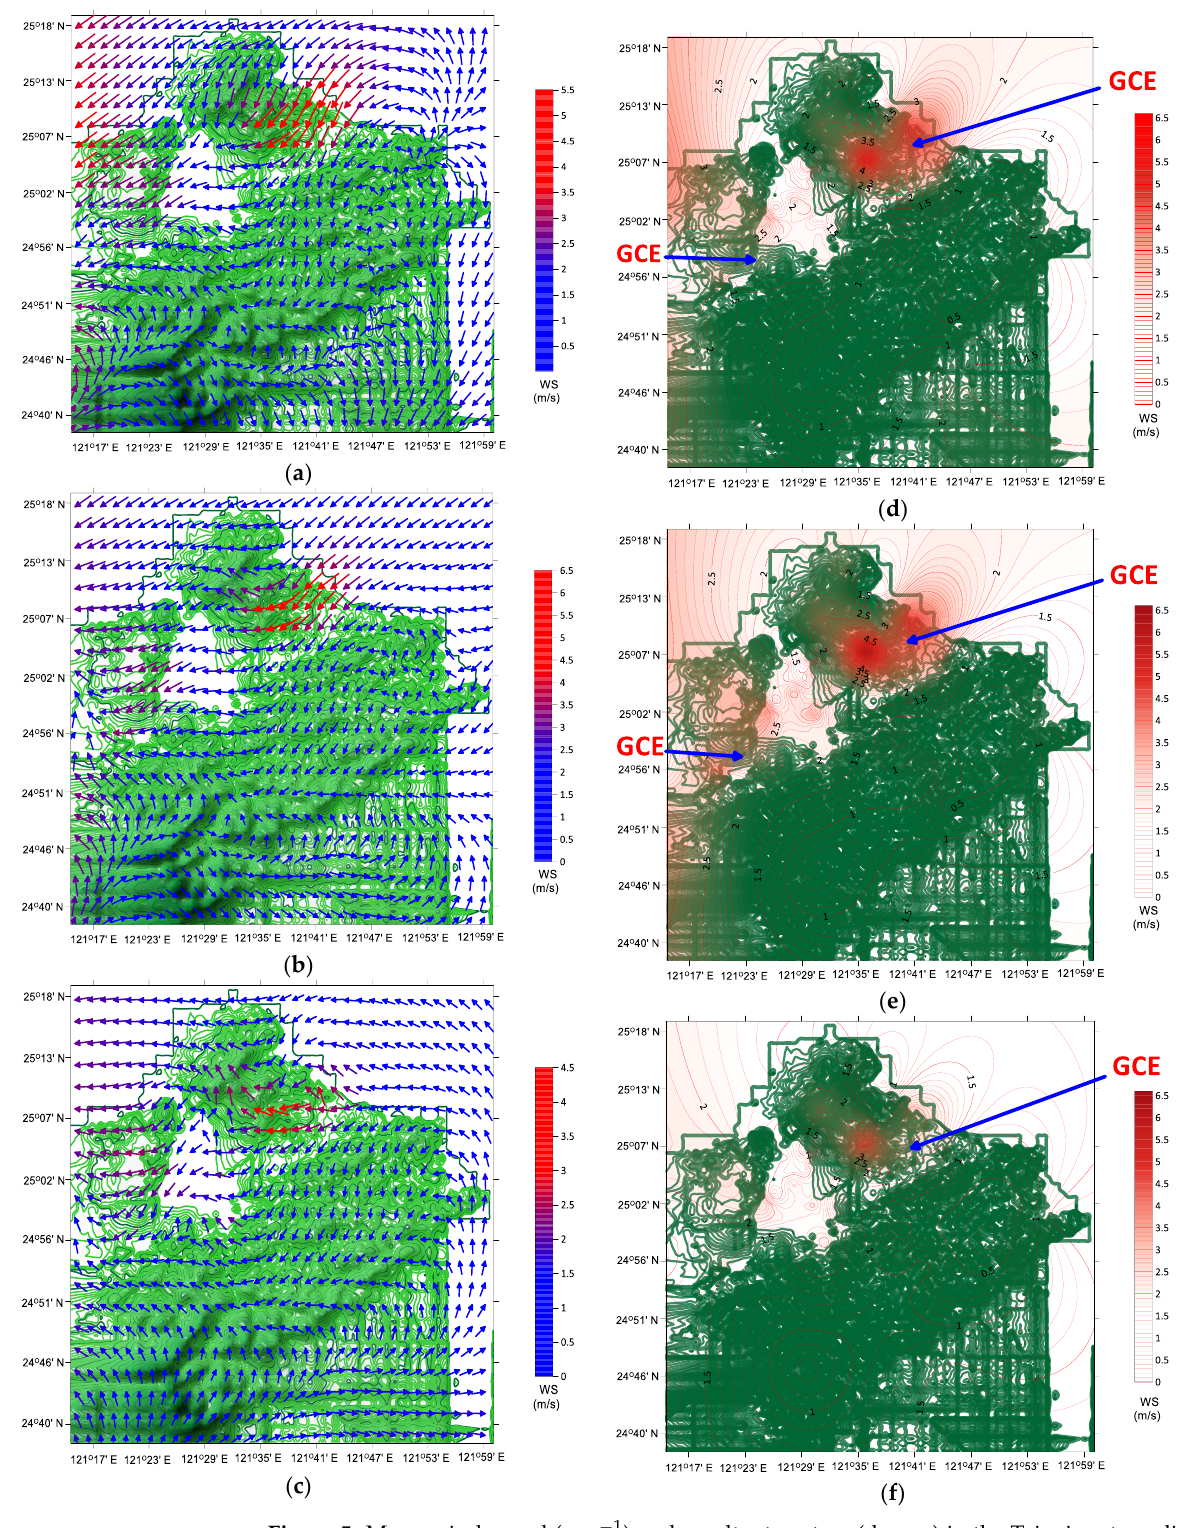
Figure 5. Mean wind speed (m·s −1 ) and resultant vectors (degree) in the Taipei metropolis when the centres of the continental high-pressure system (CHPS) were in different regions: ( a ) region- α; ( b ) region- β; ( c ) region- γ. Mean wind speed (m·s −1 ) and geographical channel effect (GCE) in the Taipei metropolis when the centres of CHPS were in different regions: ( d ) region- α; ( e ) region- β; ( f ) region- γ.